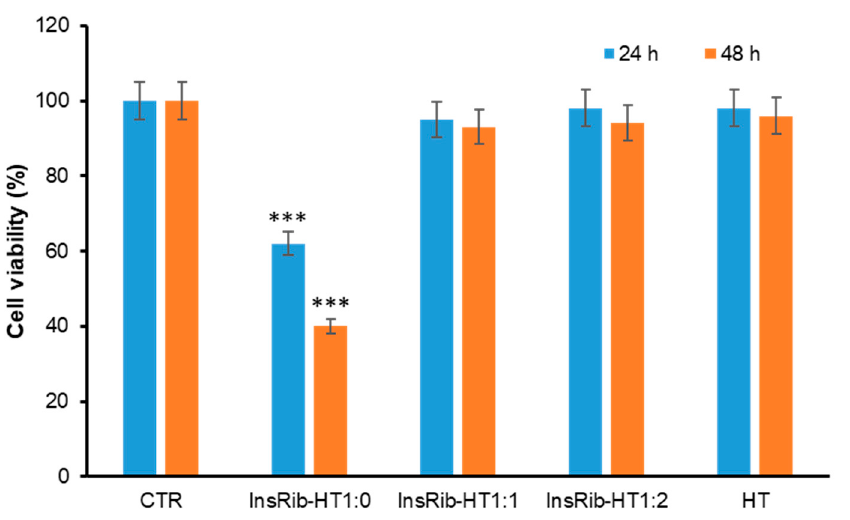
Figure 6. Effect of HT on insulin AGE toxicity. SHSY5Y cells were coincubated with glycated insulin and HT (1:0, 1:1, 1:2 molar ratio) and the cell viability was evaluated after 24 and 48 h by the MTT assay. CTR: cells treated with non-glycated insulin; HT: cells treated with HT at the higher working concentration; data are expressed as average percentage of MTT reduction ±SD relative to control cells from triplicate wells from 5 separate experiments. Other experimental details are described in the Methods section. *** p ˂ 0.001 versus CTR.